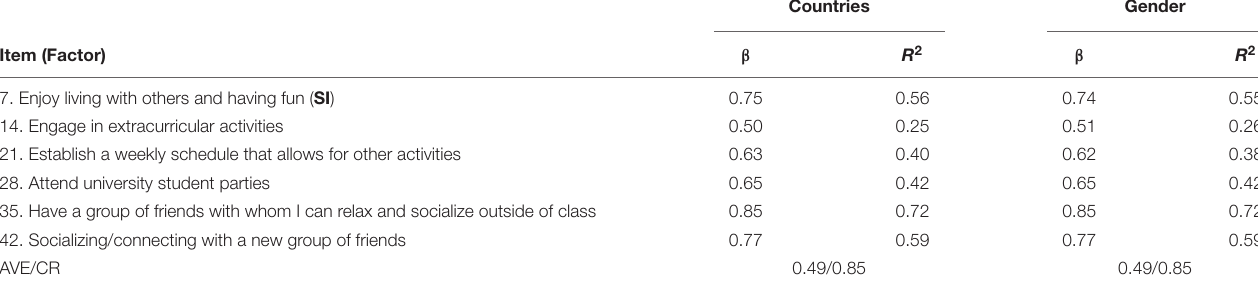
TABLE 3 | Fully invariant 9-factor oblique model by country and gender: Disattenuated correlations from the common metric completely standardized solution ( N = 1,840). PCs MAs TE PSD